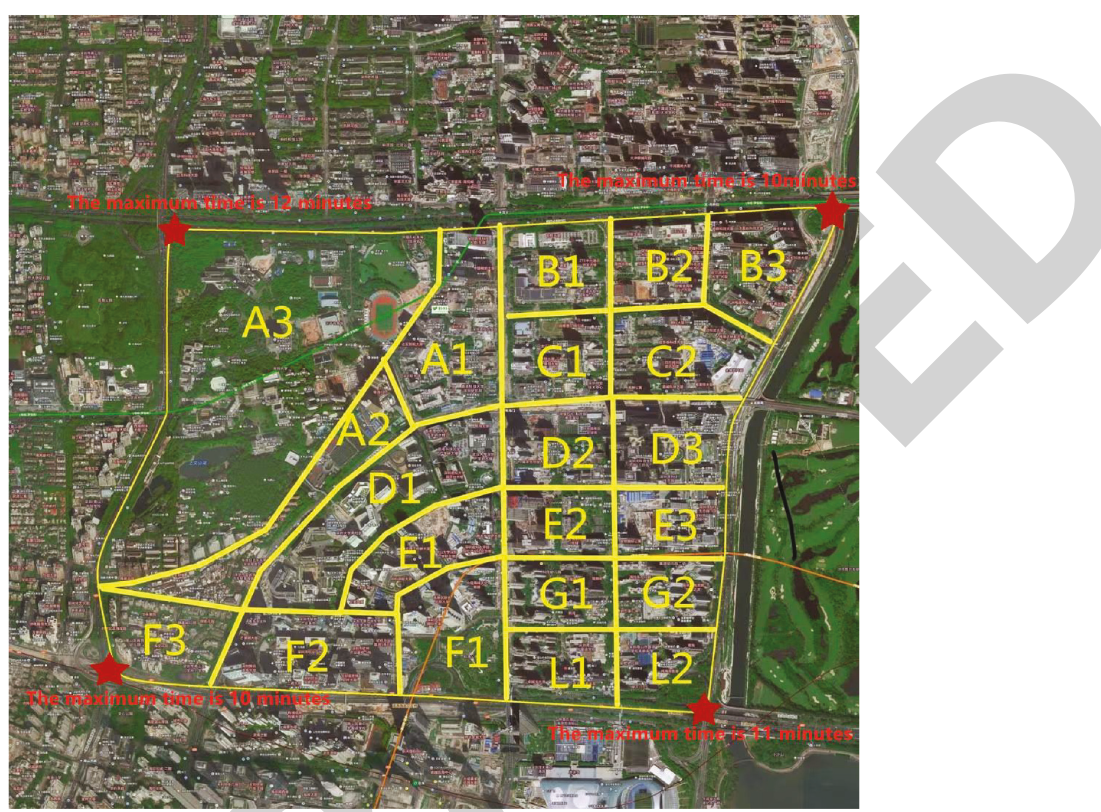
Figure 8: Identification map of distribution